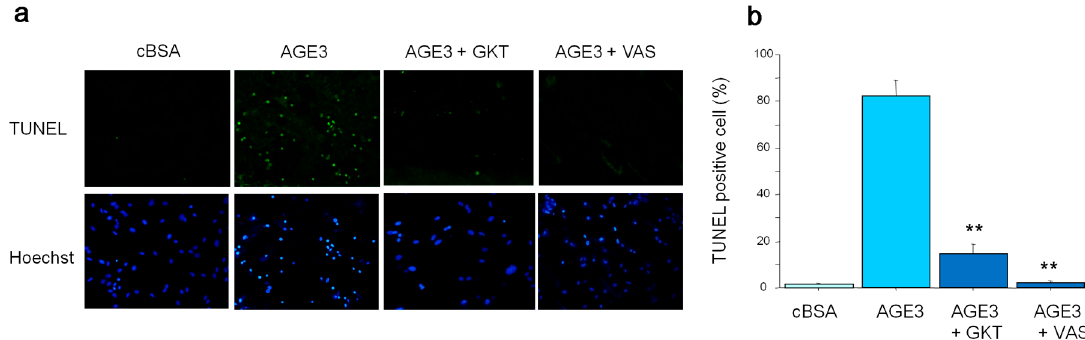
Figure 3. AGE3-BSA-induced apoptosis in A7r5 cells was mediated by NAD(P)H oxidase. ( a ) Cultured A7r5 cells were incubated in calcification medium containing cBSA, or AGE3-BSA (100 µg/mL) in the presence or absence of NAD(P)H oxidase inhibitors including GKT137831 (20 µM) or VAS2870 (10 µM) for three days. Apoptosis was evaluated by TUNEL assay, as described in the Method section. Cells in the culture were identified by nuclear staining with Hoechst, and evaluated under a fluorescence microscope; ( b ) For quantification, Hoechst and TUNEL double positive cells were counted in 10 random microscopic fields at 200× magnification, and expressed as percent TUNEL positive cells in a culture. Statistical significance of the results was analyzed by one-way ANOVA followed by LDS post-hoc test. Statistical significance was denoted as follows, ** p < 0.001 vs. AGE3-BSA.